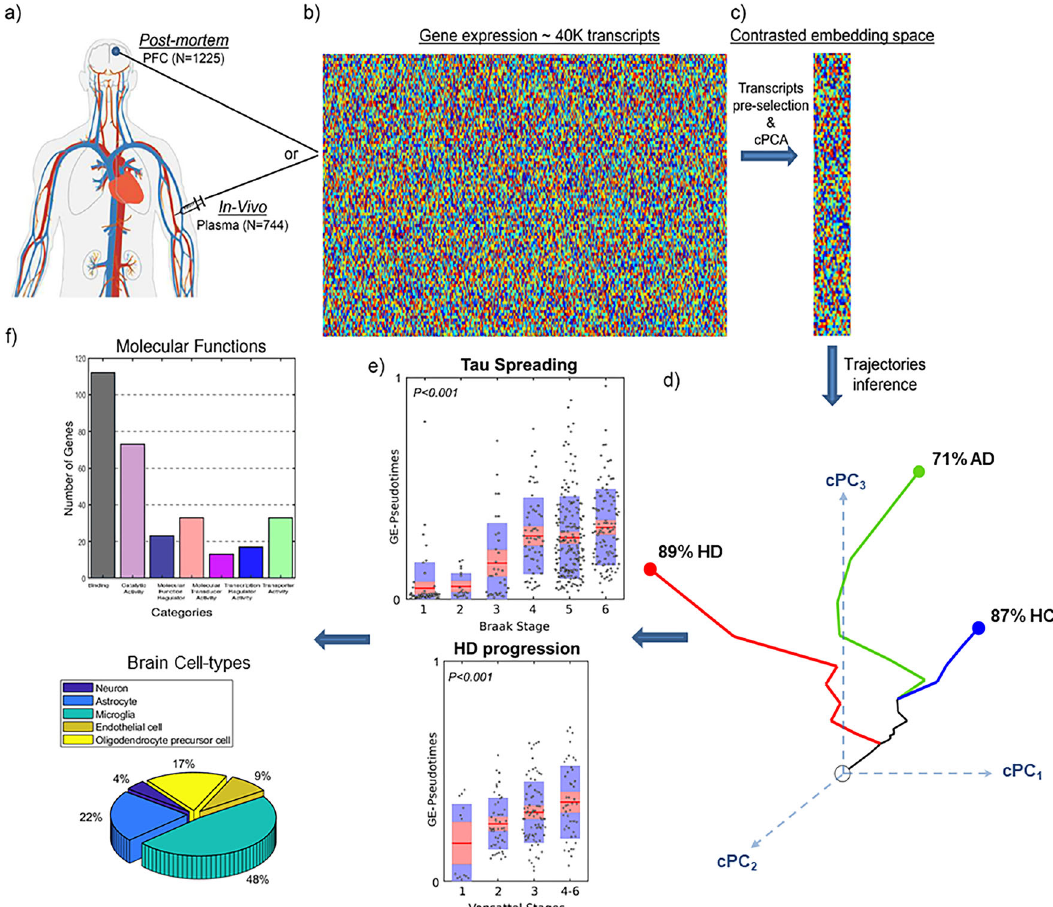
Fig. 2 Schematic of cTI application to detect disease-associated patterns and patient neuropathological stages in neurodegeneration 16 . a In vivo blood ( N = 744; ADNI) and post mortem brain ( N = 1225; ROSMAP, HBTRC) tissues, from Alzheimer ’ s disease (AD), Huntington ’ s disease (HD), and/or normal controls (HC) subjects, are screened to measure the activity of ~40,000 transcripts. b Each population ’ s high-dimensional data are reduced to a set of disease-associated components via c contrastive principal component analysis (cPCA) 21,62 . d This allows each subject to be represented in a reduced n- dimensional disease-associated space where the corresponding position re fl ects his/her pathological state (proximity to the bottom-left corner implies a pathology-free state; conversely, the top-right corner implies advanced pathology). For instance, when analyzing the GE data from the HBTRC ’ s highly heterogeneous population (including HC, LOAD, and HD subjects, total N = 736), the high-dimensional data were reduced to seven contrasted PCs [cPCs] capturing up to 97.5% of the population variance (and individually explaining 38.73%, 19.91%, 16.18%, 8.46%, 5.85%, 5.50%, and 2.87% of the variance, respectively). Notice that, for visualization simplicity, here were only represented the fi rst three cPCs, but the quantitative analysis considers all identi fi ed components. Within this cPCs space, each subject is automatically assigned to a disease trajectory that represents a subpopulation of subjects potentially following a common disease variant (see “ Methods ” ). The number of subpopulations (disease trajectories) is determined automatically based on how the subjects “ cluster ” together in the disease-associated space. e An individual molecular-disease score is then calculated, re fl ecting how advanced each subject is in his/her disease trajectory. This score signi fi cantly predicts neuropathological deterioration. f Finally, the resulting model weights (from contrastive PCA) allow the identi fi cation and posterior functional analysis of most in fl uential genes/features. Panels a – c , e , f adapted with permission from ref. 16